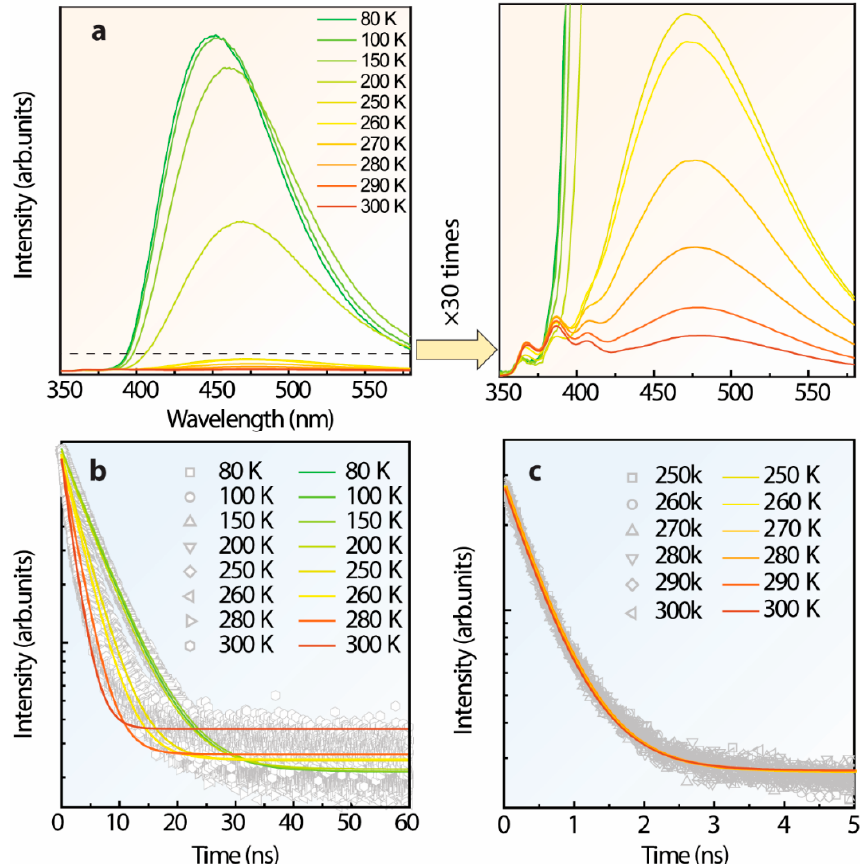
Figure 7. ( a ) Temperature-dependent emission spectra of S-TPE-1 (after 30 min of heat treatment under 70 °C, solid state gel), illustrated with the zooming area, ( b , c ) corresponding time-resolution intensity decay curves by monitoring the emission centered at 480 and 386 nm, respectively.